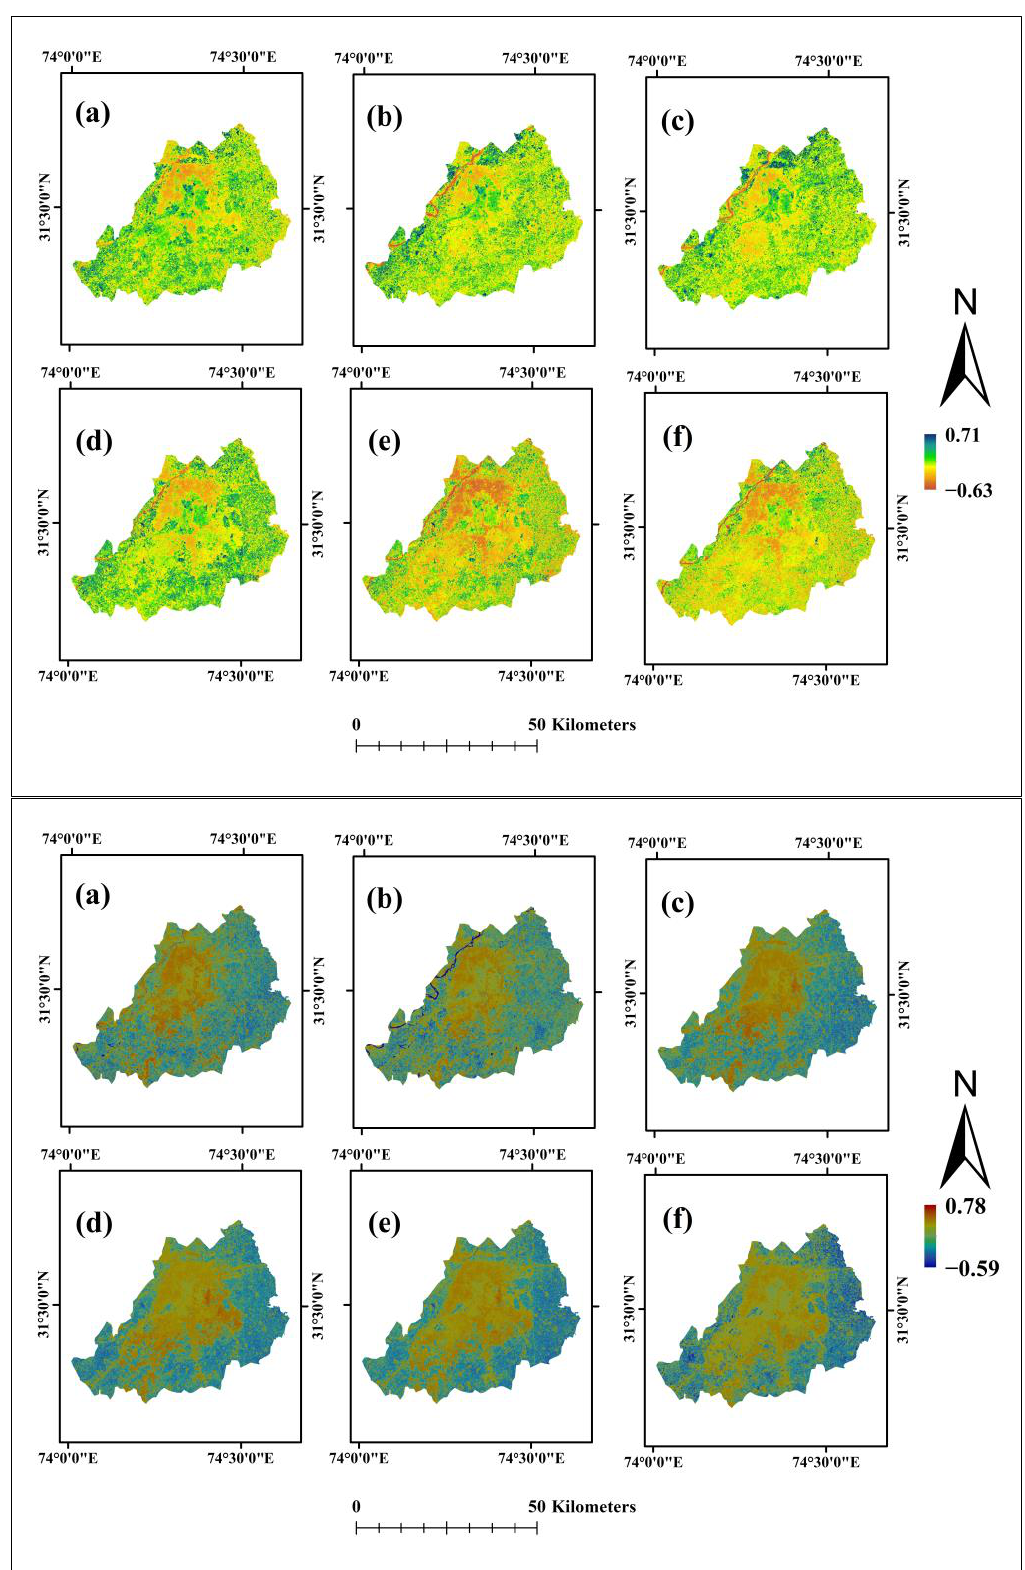
Figure 5. NDVI (Top) and NDBI (bottom) maps of Lahore city (ranging from − for the year ( a ) 1992, ( b ) 1996, ( c ) 2000, ( d ) 2008, ( e ) 2014, and ( f ) 2020.